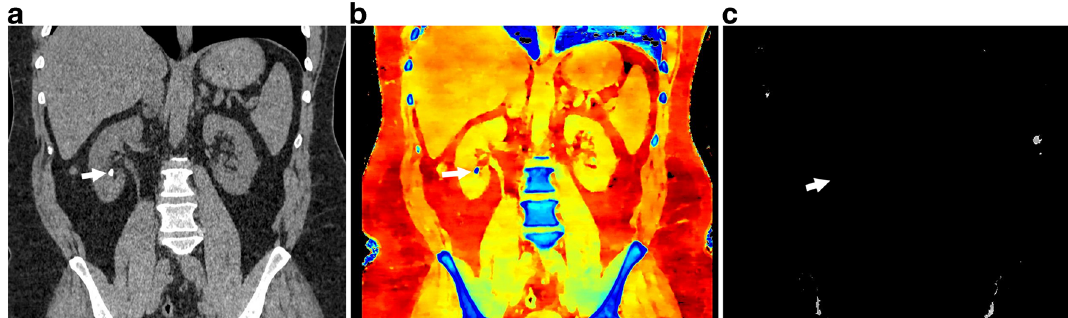
calculus has high atomic number ( arrow ) consistent with a calcium calculus. ( c ) Uric acid image shows no focal abnormality in the area corresponding to calculus ( arrow ), indicating that the calculus does not have uric